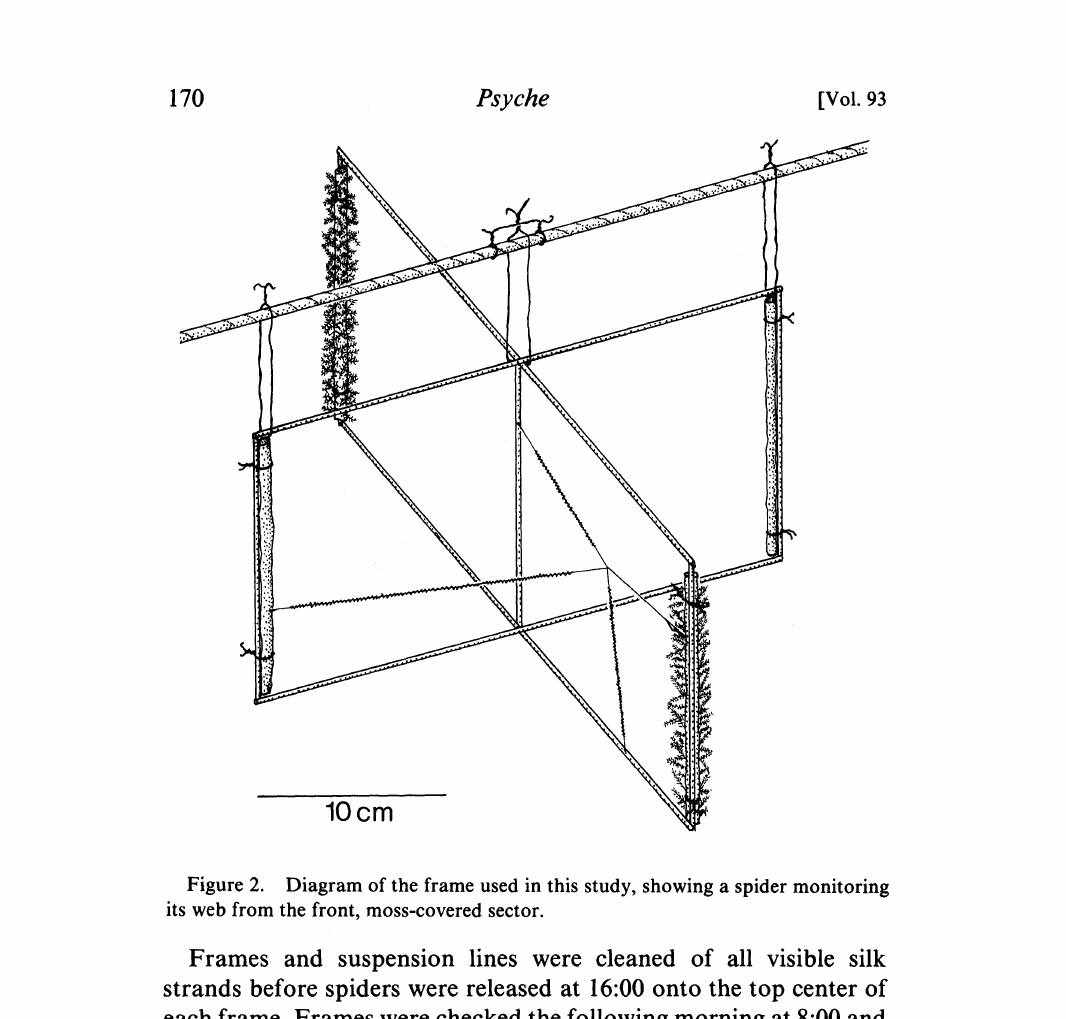
Figure 2. Diagram of the frame used in this study, showing a spider monitoring its web from the front, moss-covered sector. Frames and suspension lines were cleaned of all visible